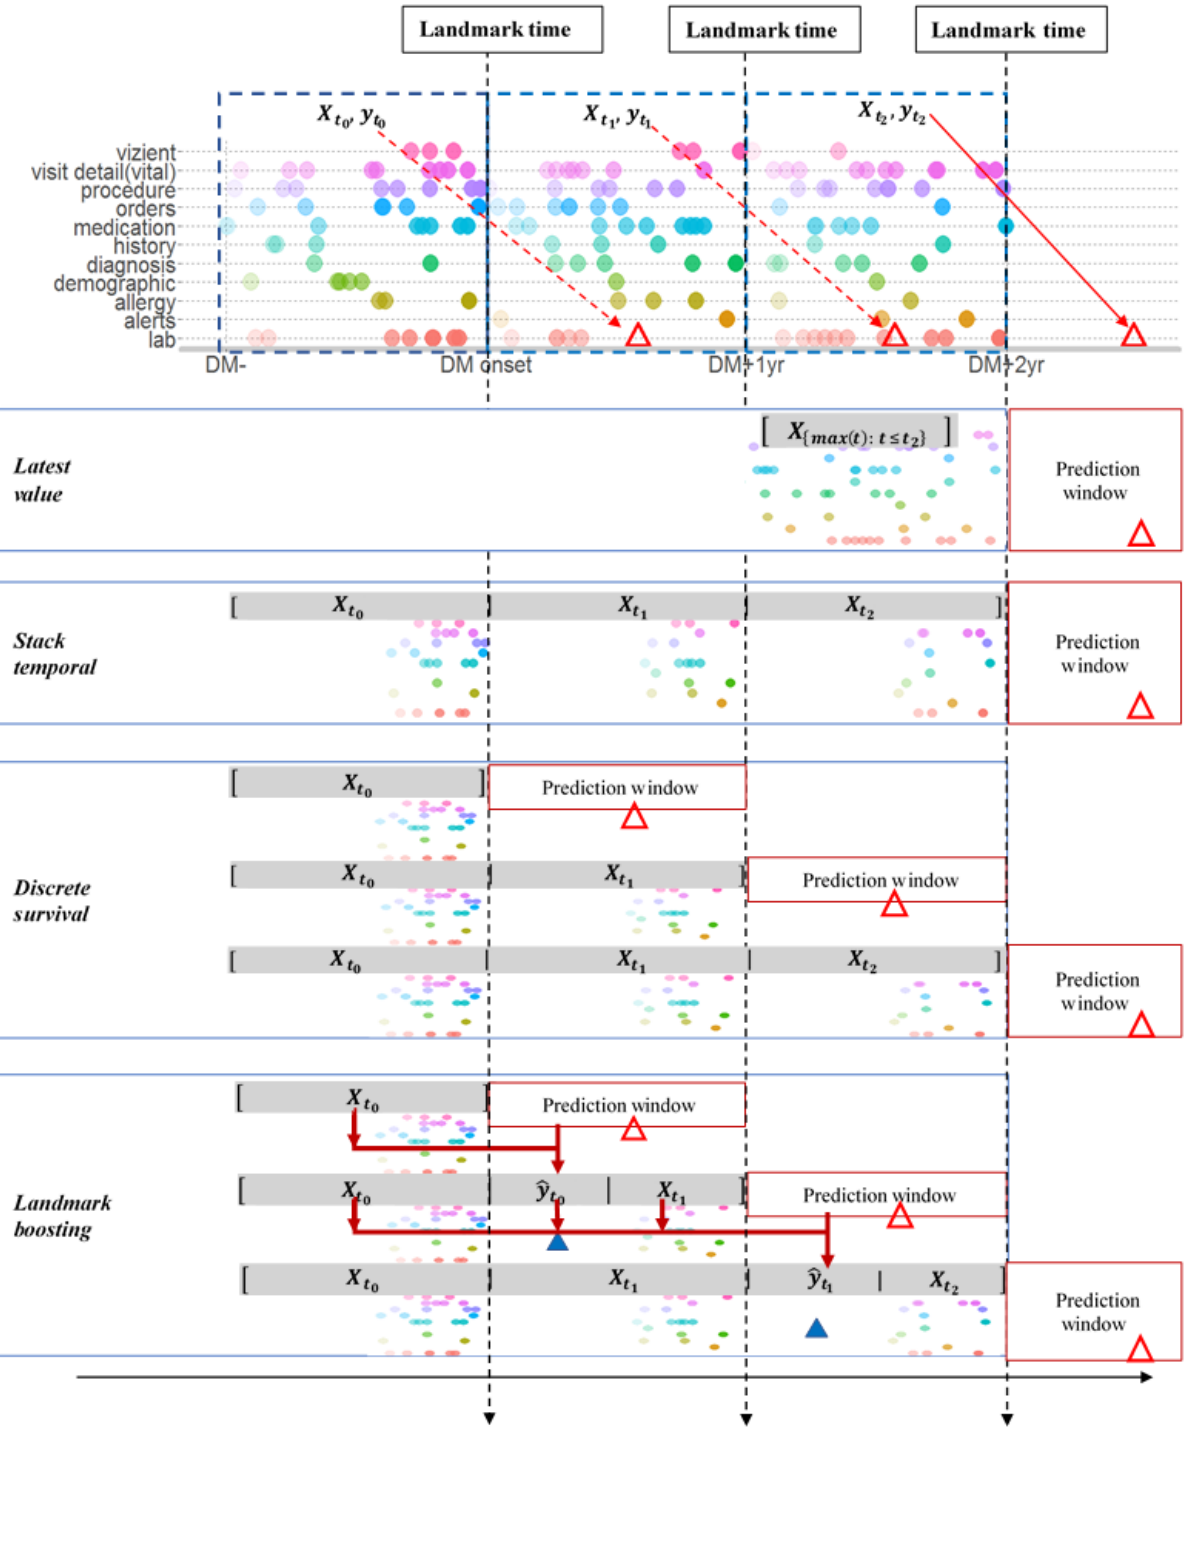
Figure 3. Illustration of the temporal approaches, which are Latest-Value, Stack-Temporal, Discrete-Survival, and Landmark-Boosting from top to bottom. Different colors of circles represent different types of clinical data. Red triangles represent real values of the outcome (ie, diabetic kidney disease (DKD) or non-diabetic kidney disease in the following prediction window). Blue triangles represent predicted outcome based on clinical features presented in the previous observation window. Xti denotes all available clinical features collected strictly before landmark time ti (ie, number of full years since DM onset). yti denotes real label of DKD onset after within the prediction window (ti, ti+1). DM: diabetes